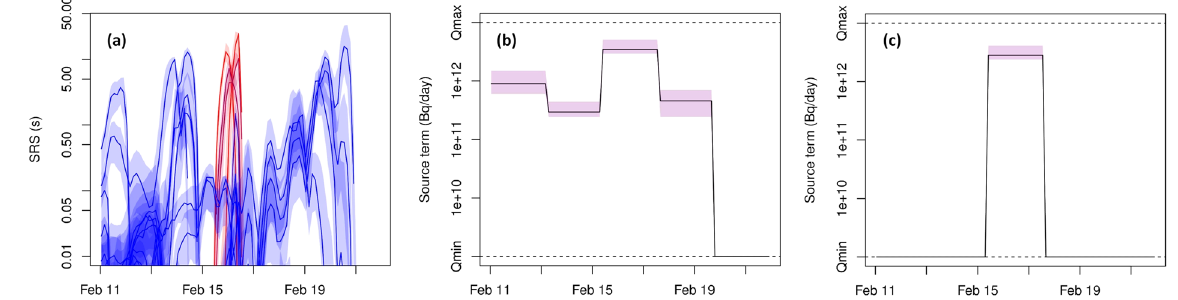
Figure 4. ( a ) SRS values at the Punggye-ri nuclear test site for each sample considered in the inverse modelling as a function of time; colours are semi-transparent and proportional to the sample’s observed 133 Xe concentration (blue: lowest concentration; red: highest concentration). ( b ) Possible 133 Xe release at the Punggye-ri site as a function of time. ( c ) Possible 133 Xe release at the Punggye-ri site as a function of time but with all samples equal to or below 0.3 mBq reset to zero. The shadings represent values within the 2.5% and 97.5% quantile of the ensemble.